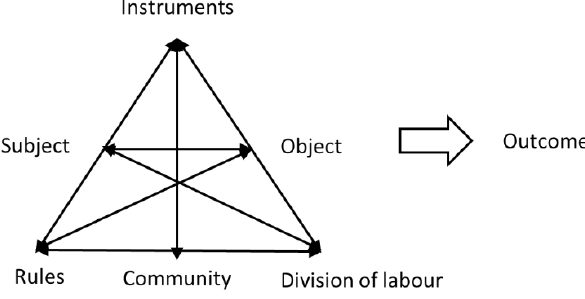
Figure 1. Basic model for structuring an activity (reproduced from [23], p. 63, with kind permission of the